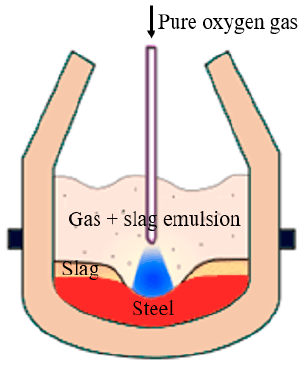
Figure 1. Converter steelmaking process.